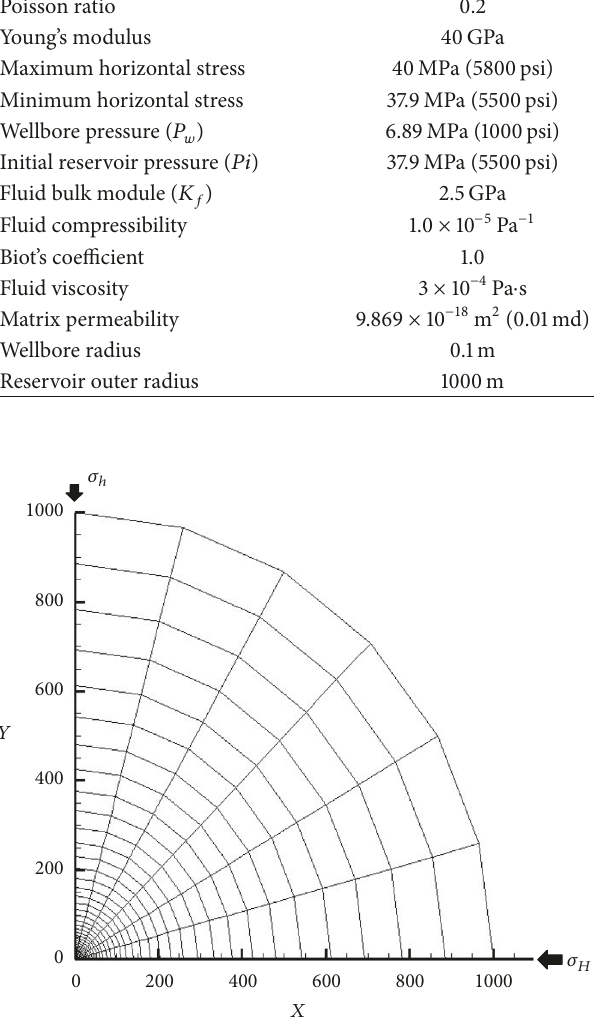
Figure 1: Two-dimensional circular reservoir shape used for valida- tion of poroelastic numerical model with 𝜎 𝐻 = 39.9 MPa and 𝜎 ℎ = 37.9 MPa, 𝑃 𝑟 = 37.9MPa, and Δ𝑝 =